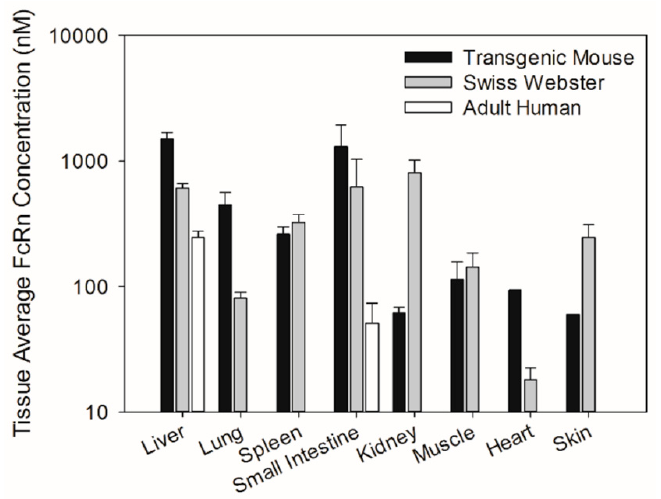
Figure 3. Comparison of tissue FcRn protein expression among Swiss Webster mice, transgenic mice, and humans. The data are expressed in tissue average FcRn concentration. Data are mean ± SD from 5 Swiss Webster mice, 3 transgenic mice, liver samples from 3 adult human subjects, and GI samples from 3 adult human